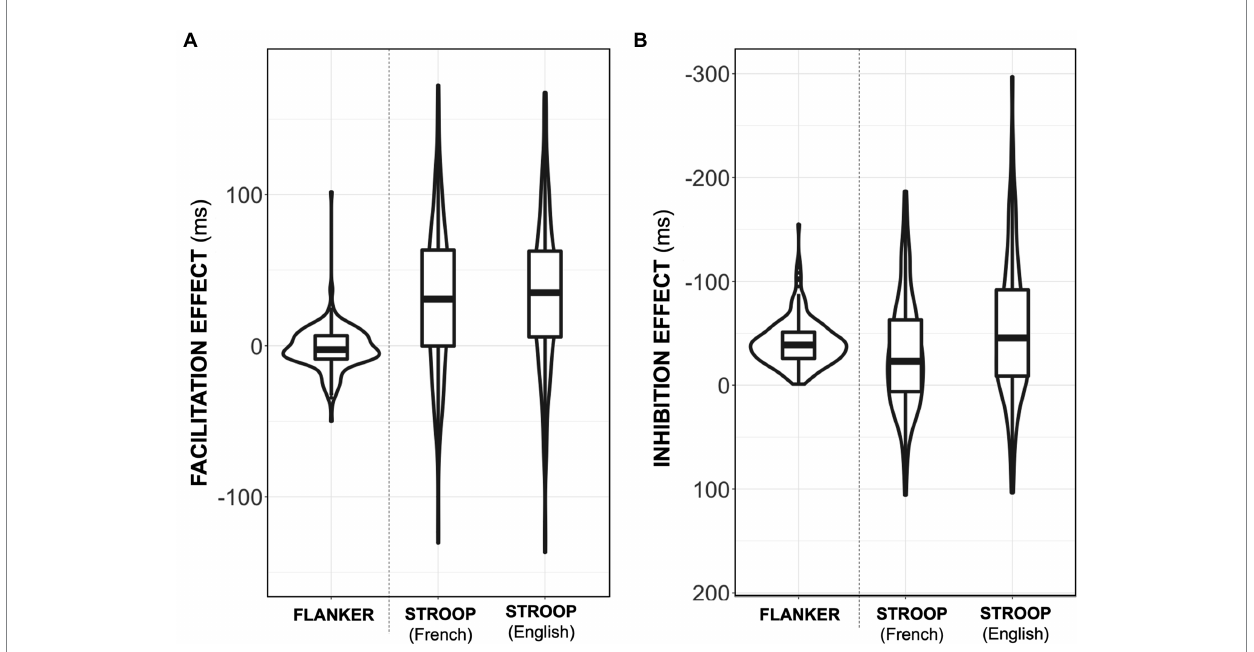
FIGURE 3 (A) Individual variation in the Facilitation effect (neutral—congruent trials) for both tasks. (B) Individual variation in the Inhibition effect (neutral— incongruent trials) for both tasks. For each variable, the thick black line represents the median, the outline of the box represents the inter-quartile range, the whiskers of the boxplot represent the maximum and minimum values, and the violin outline illustrates the density of the data. Note that for the inhibition effect, negative is plotted up.